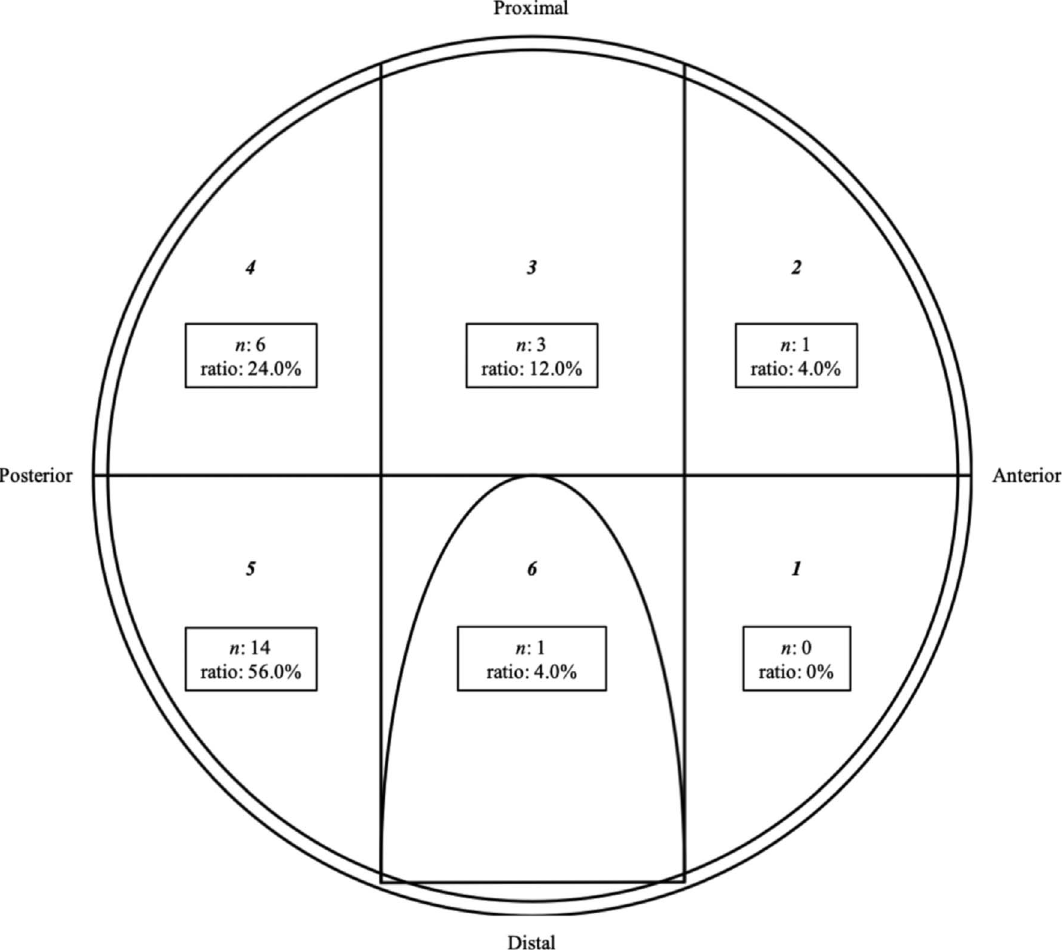
Figure 2. The presence and location of partial damage in the acetabular cartilage documented using a geographic zone method. The partial damage lesions in the acetabular cartilage were assigned numbers and ratios (the number of lesions divided by the total number of lesions) correlating with their zone. Overall, 25 lesions of partial damage were found in 16